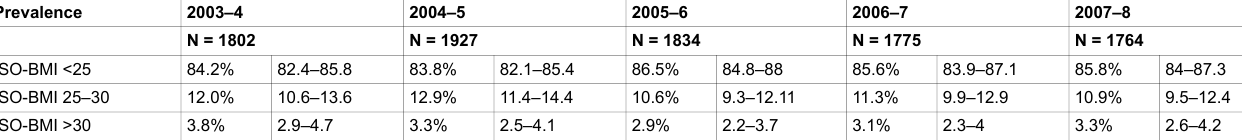
ISO-BMI >30 Table 2 Distribution of prevalence (95% confidence intervals) divided into ISO-BMI subgroups for girls.